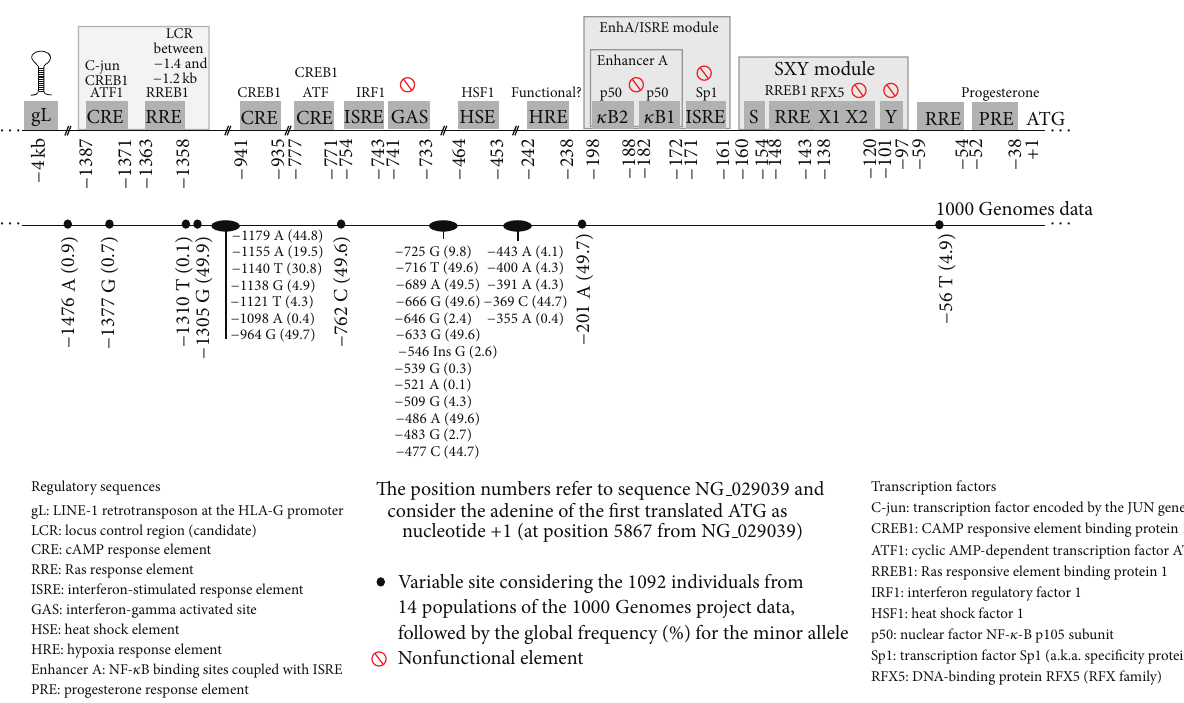
phosphorylation of Stat1 (JAK/STAT pathway) [19, 21].